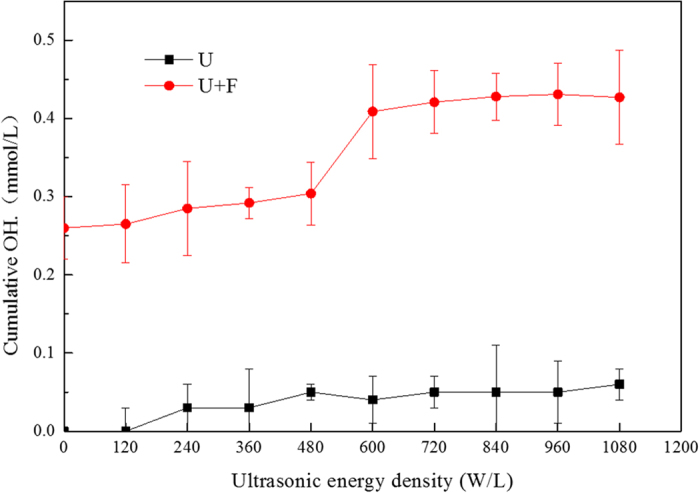
OH• concentration detected using a fluorescence spectrophotometer.Treatment time was 20 min, Fe2+ concentration was 0.4 g/L, and H2O2 concentration was 0.5 g/L.